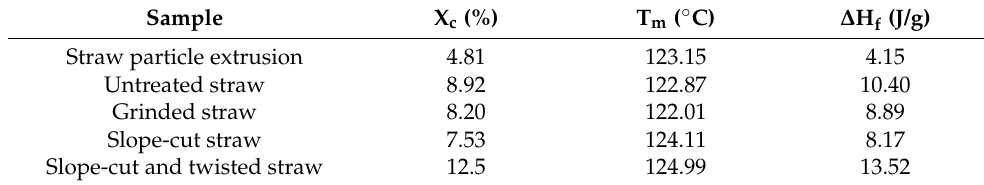
Table 1. Crystallinity, melting enthalpy, and melting temperature of straw/LLDPE composites.